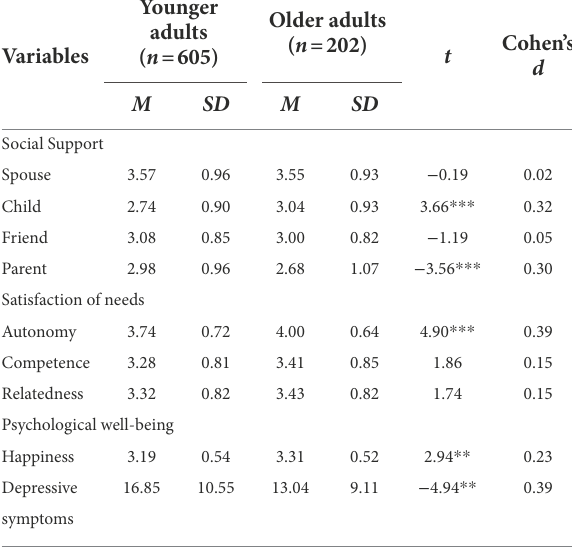
TABLE 3 Age-group differences on all research